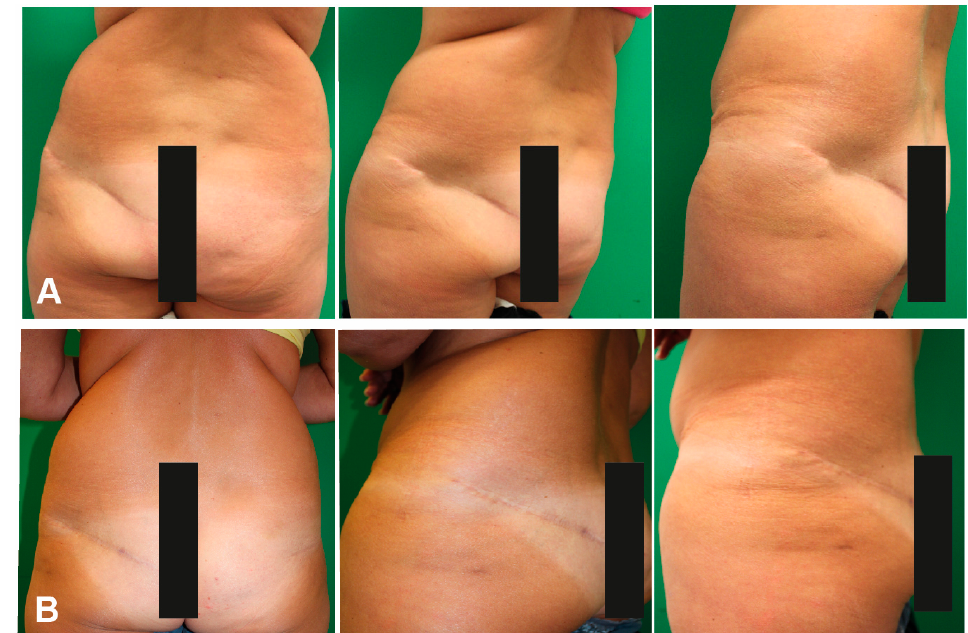
Figure 2. ( A ) Preoperative donor site scar after S-GAP flap harvest for breast reconstruction, ( B ) 3 month postoperative outcome after